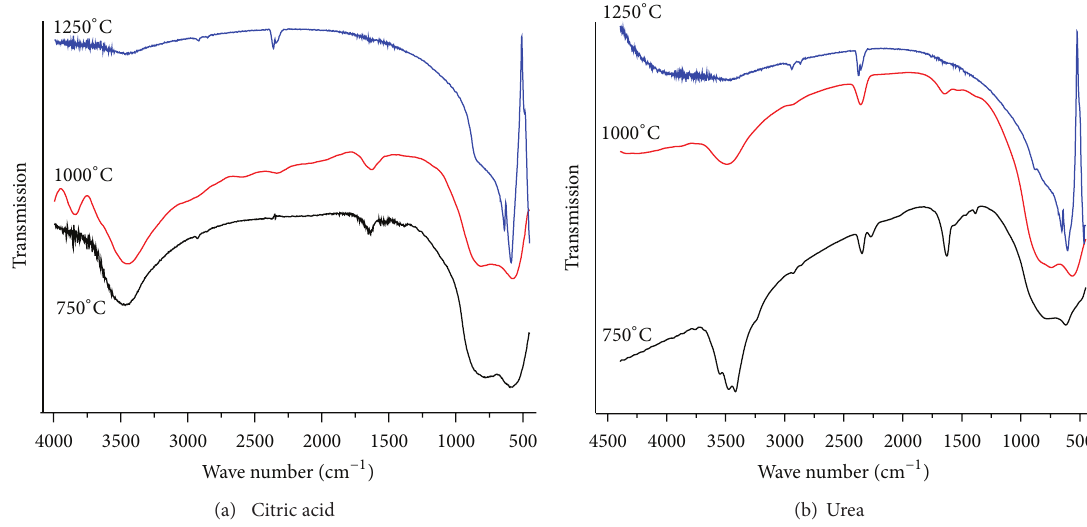
Figure 7: FT-IR spectrums of Al 2 O 3 nanopowders prepared with complexing agent. (a) Citric Acid and (b) urea calcined at various temperatures. Table 3: BET surface area of powders and the particle size versus annealing temperatures. Complexing